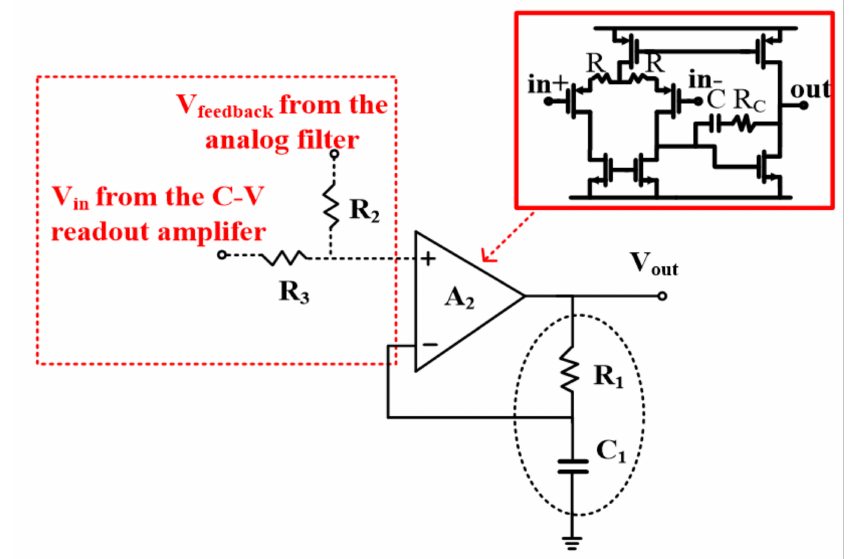
Figure 11. PD stabilization